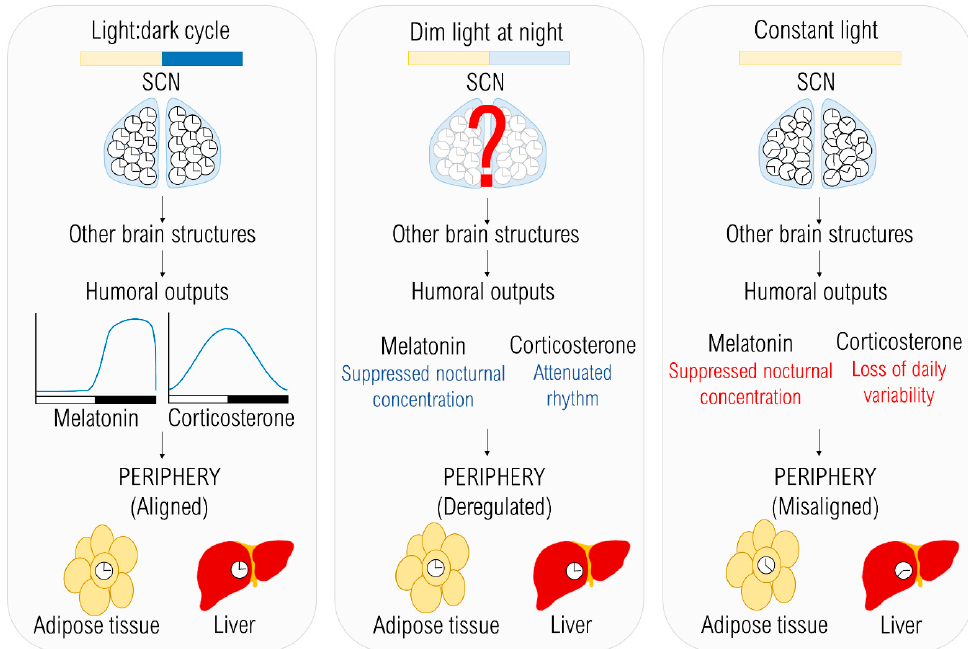
Figure 1. The effects of different lighting conditions on the temporal organization. The light:dark (LD) cycle provides an environmental cue entraining individual clocks in the suprachiasmatic nucleus (SCN), which are in synchrony with each other. Due to the entrained master pacemaker, humoral outputs are rhythmic and peripheral oscillators are also entrained to the LD cycle. In dim light at night (dLAN) conditions, the synchronizing cue is weaker than in LD, but exact mechanisms of how dLAN affects the central oscillator are not known yet. Melatonin and corticosterone rhythms are attenuated in rats (blue) and together with other internal signals can cause the deregulation of peripheral oscillators. In constant light (LL), which is a strong chronodisruptor, decoupling of individual clocks in the SCN occurs, resulting in disrupted rhythms of humoral outputs (red) and misalignment among peripheral clocks.